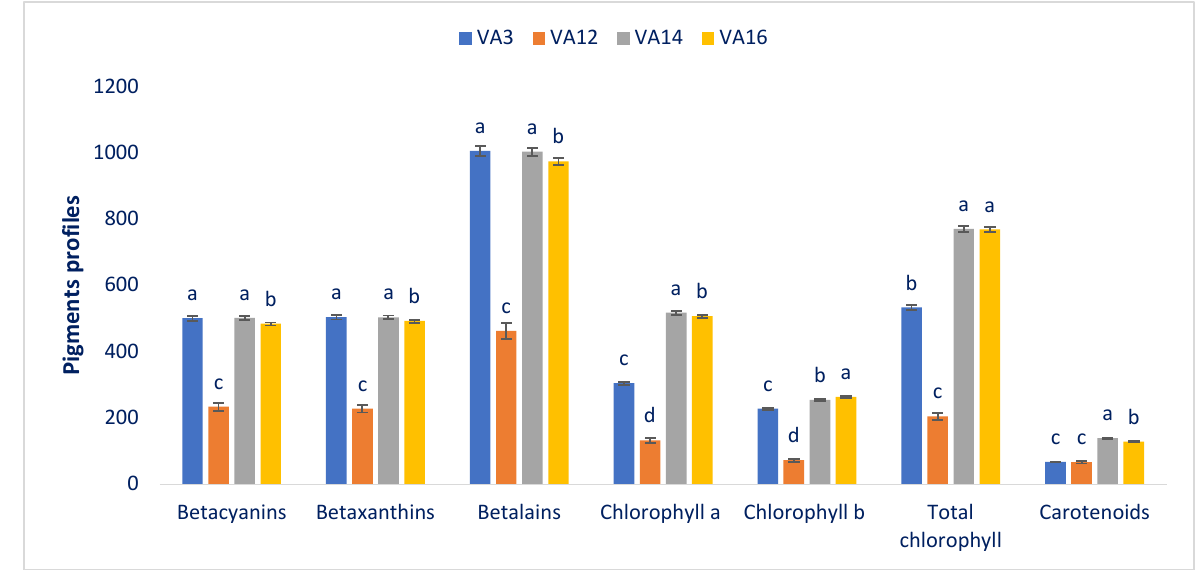
Figure 4. Bioactive phytopigment contents of drought-resistant amaranth (betacyanins (ng g −1 FW), chlorophyll a (μg g −1 FW), betaxanthins (ng g −1 FW), chlorophyll b (μg g −1 FW), betalains (ng g −1 FW), total chlorophyll (μg g −1 FW), total carotenoids (mg 100 g −1 FW)). Dissimilar letters indicate statistical